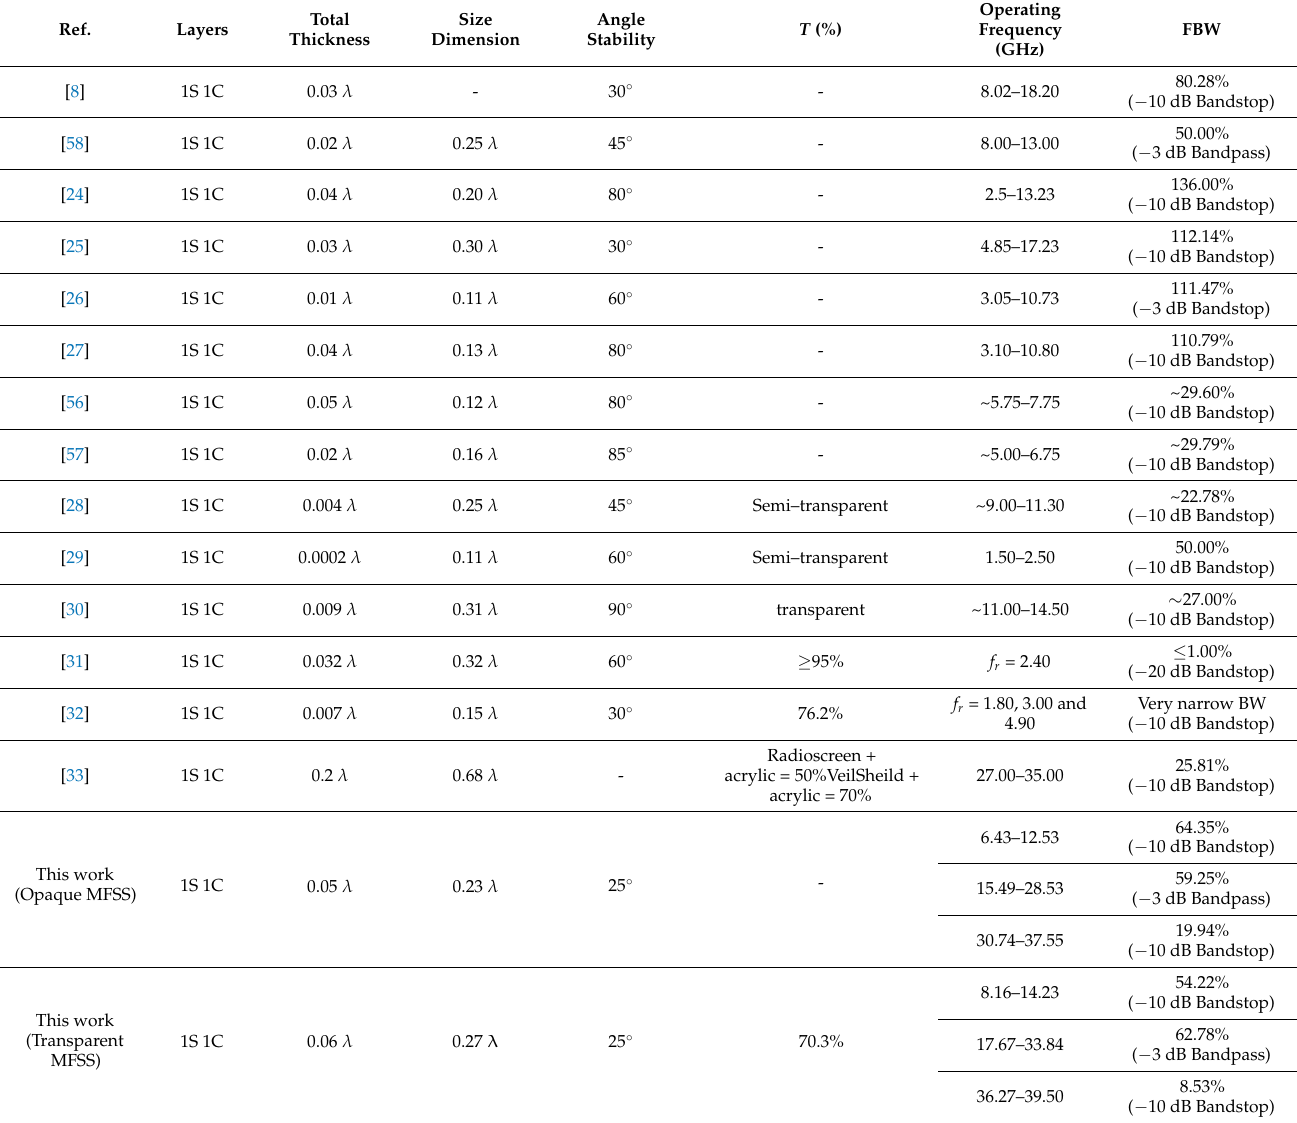
Table 2. The comparison of the opaque and transparent MFSS with previous